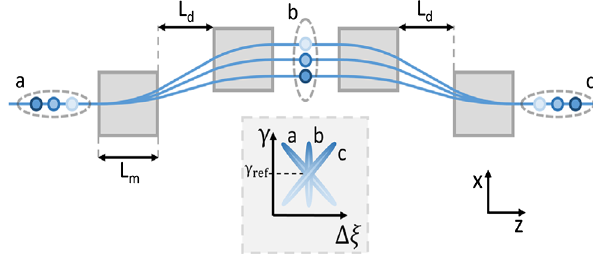
FIG. 8. Inversion of the beam energy chirp in a magnetic chicane between two identical LPAS. The longitudinal phase space is shown at the chicane (a) entrance, (b) middle, and (c) exit. Darker color means higher energy